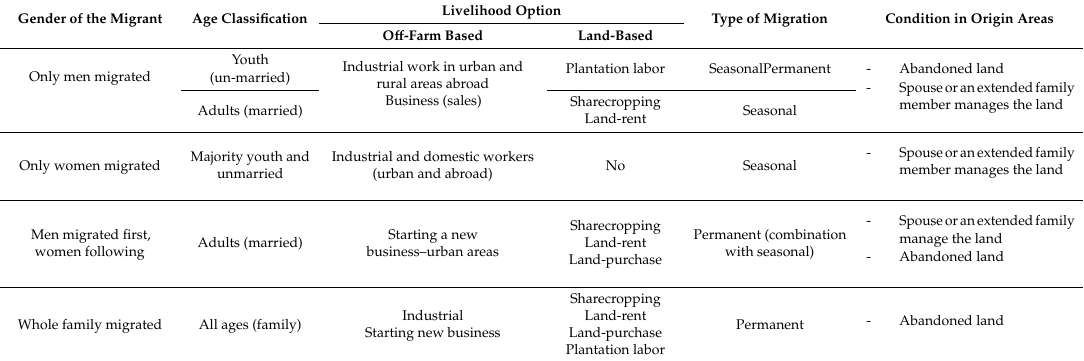
Table 3. Livelihood options based on the type of migration, age, and gender.